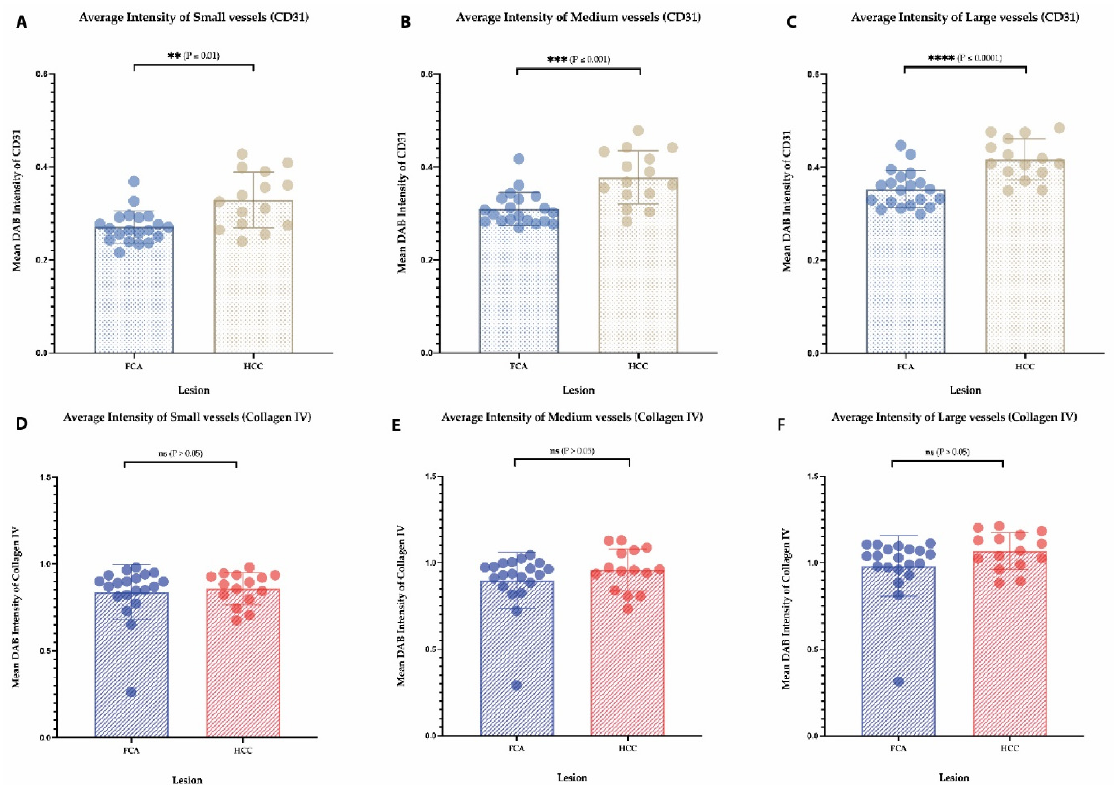
Figure 5. Analysis of staining intensity per lesion of CD31- and Collagen IV-stained vessels (A–F). Error bars indicate the mean and standard deviation for each lesion. p -values: Not statistically significant (ns) p value > 0.05; for statistical significance, accepted p value ≤ 0.05. ** p value ≤ 0.01, *** p value ≤ 0.001, and **** p value ≤ 0.0001.